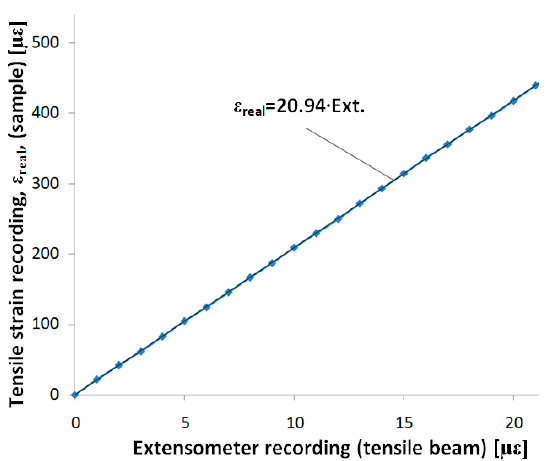
Figure 4. Tensile calibration with the Wheatstone bridge connected to the Vishay bridge P3—the signals from the extensometer and control sample are in με .